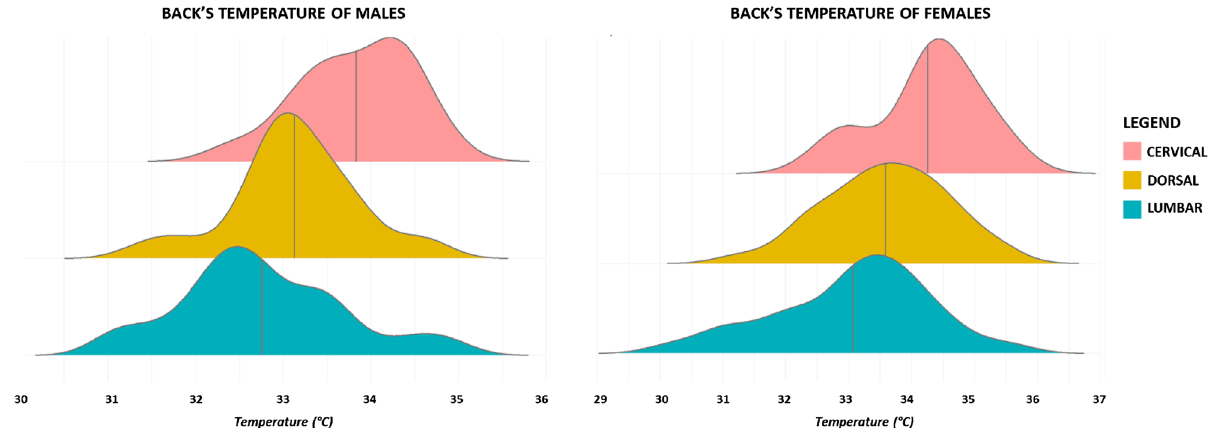
Figure 3. Ridge plots of temperature distribution for males and females. The vertical line in each plot represents the mean